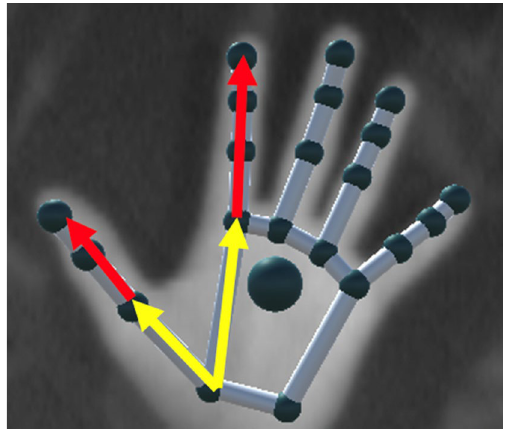
Figure 7. For each finger, the angle between the metacarpal segment (yellow arrow) and the extremity of the last phalanx is computed (red arrow). For the thumb the first phalanx is taken into consideration instead of the metacarpal